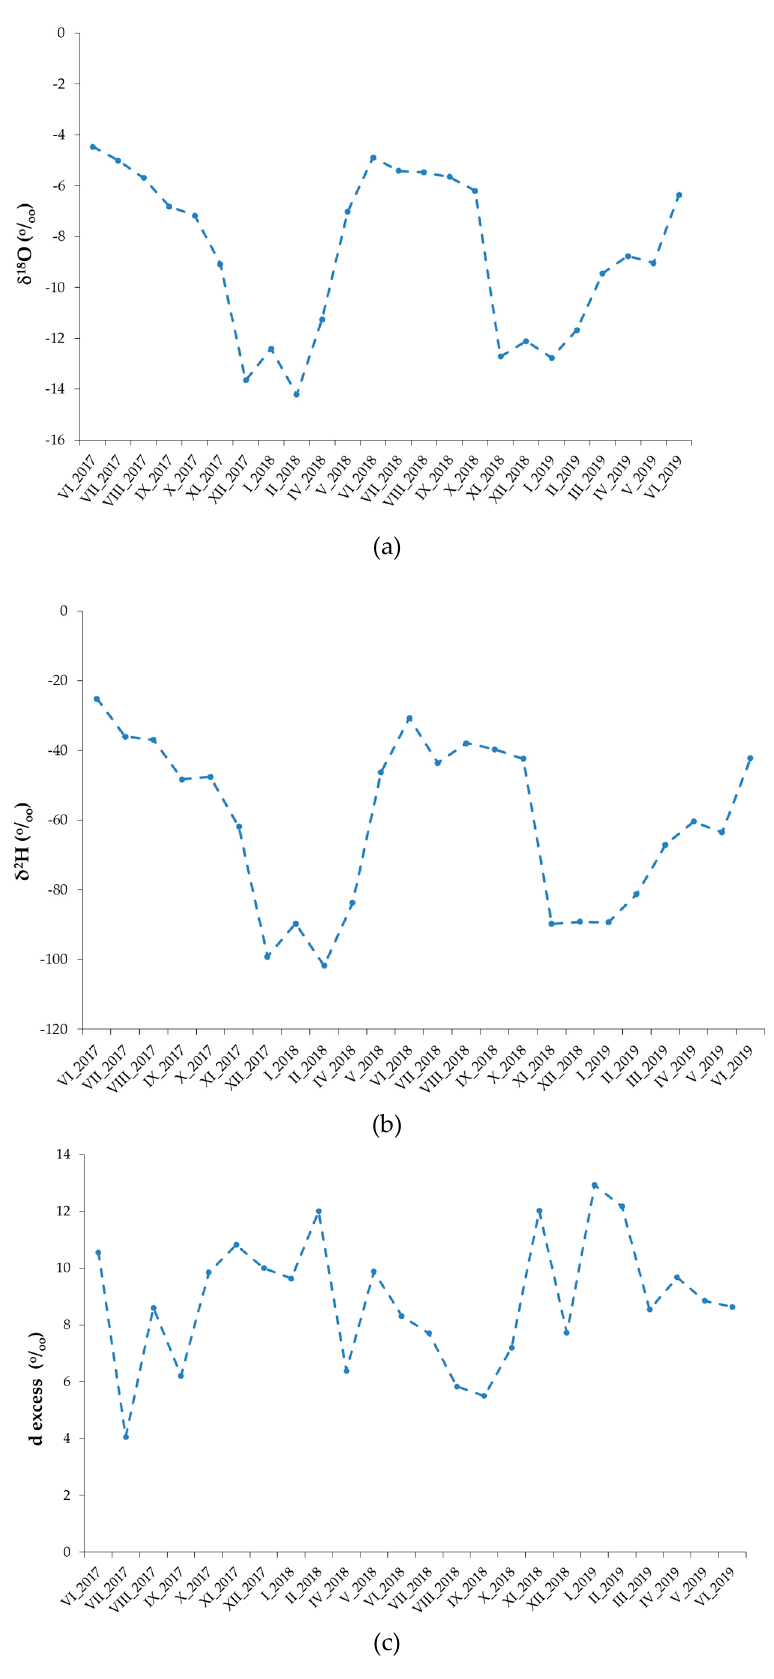
Figure 4. Monthly variations of ( a ) δ 18 O ( o / oo ) values, ( b ) δ 2 H ( o / oo ) values, and (c) d-excess ( o / oo ) in precipitation at the rain gauge in